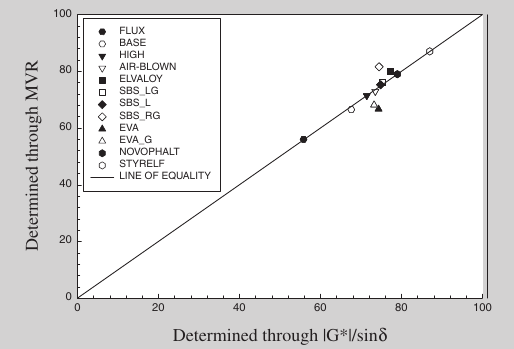
Figure 14: Comparison between the high tempera- ture PG determined through MVR and that determined through |G*|/sin d